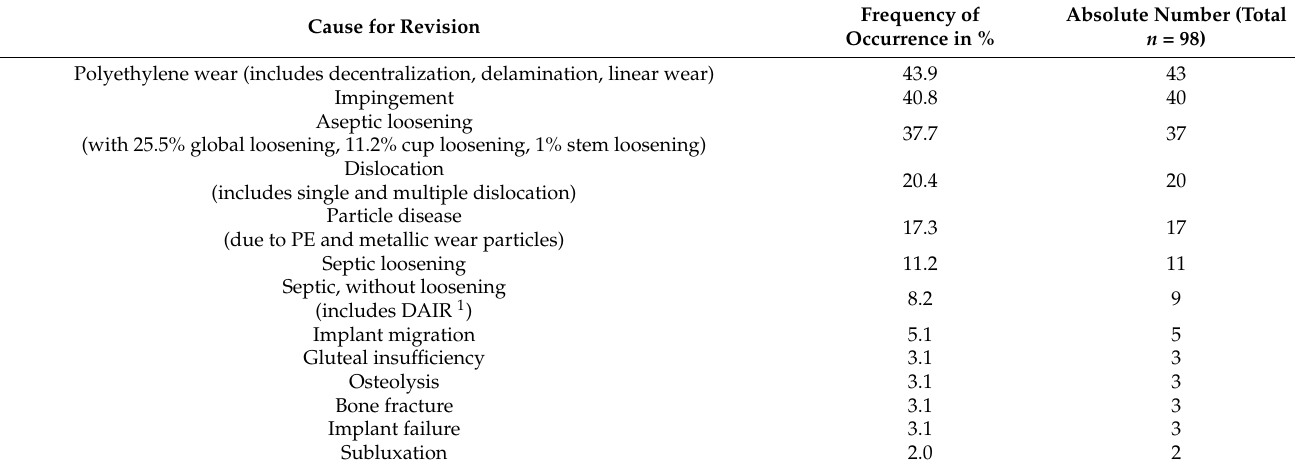
Table 2. Occurring causes for revision of the examined